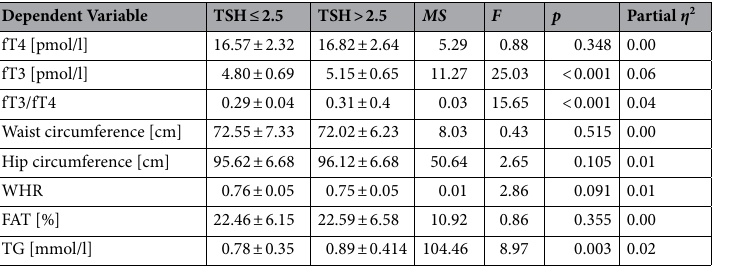
Table 2. The results of single between-subject effects tests for TSH factor. W HR waist hips ratio, data in TSH columns were presented as mean ± standard